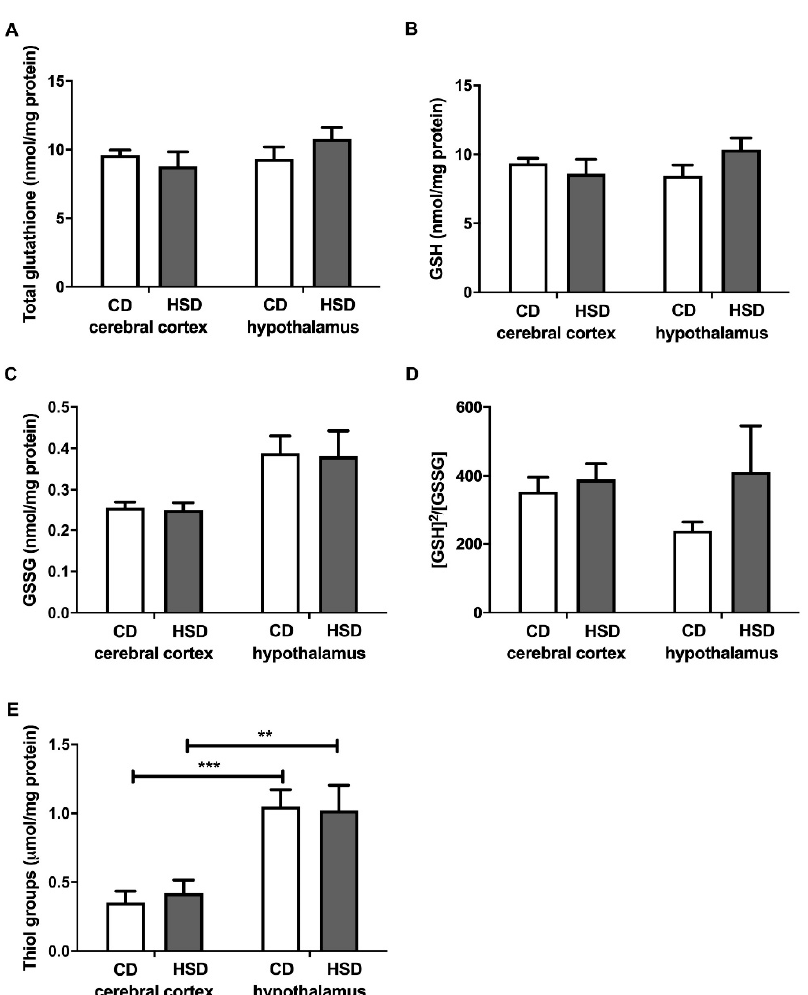
Figure 3. Brain glutathione metabolism (total glutathione ( A ), reduced glutathione ( B ), oxidized glutathione ( C ), the oxidation / reduction ratio ( D ) and thiol groups ( E )) in the control and HSD-fed rats. Values are means ± SEMs; n = 10 * differences statistically important at p < 0.05, ** p < 0.005 and